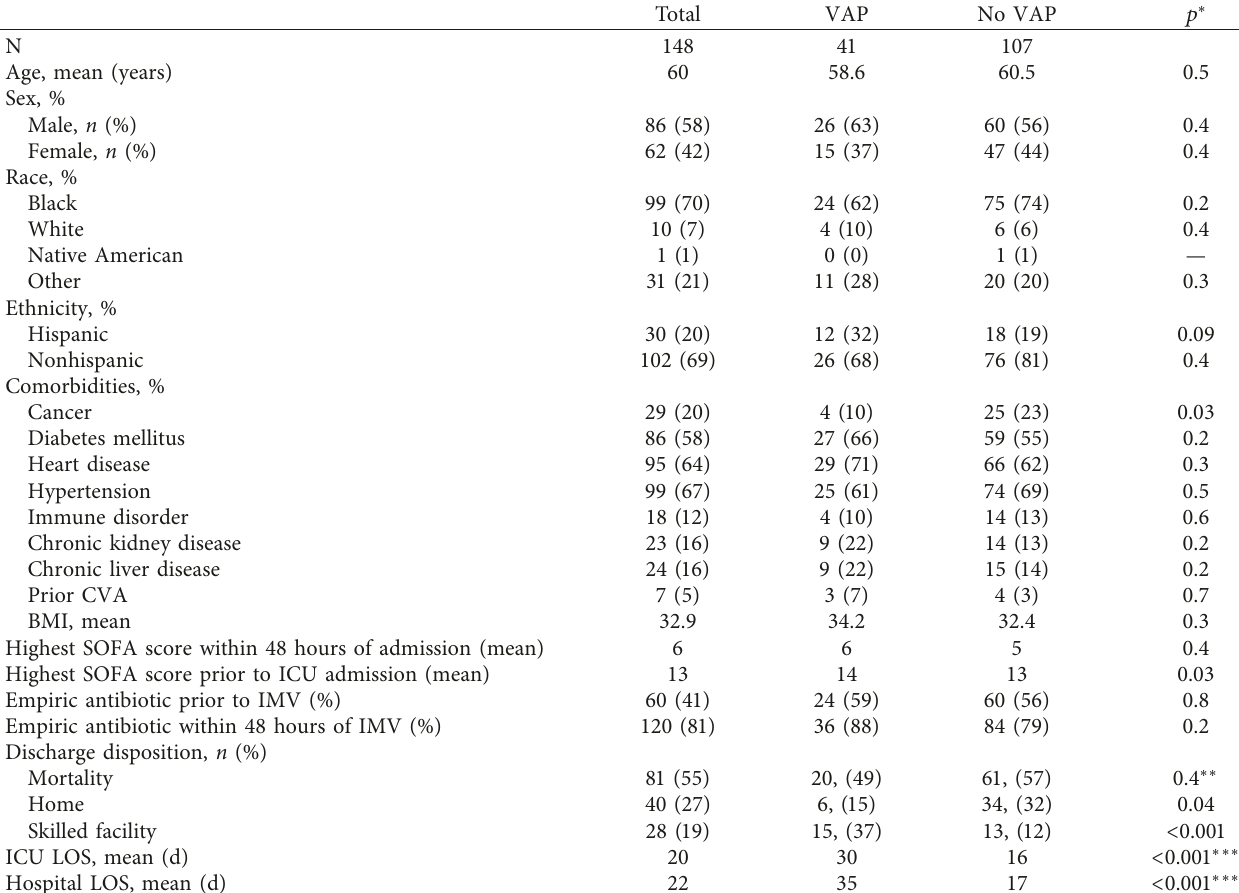
Table 1: Demographic and comorbidity